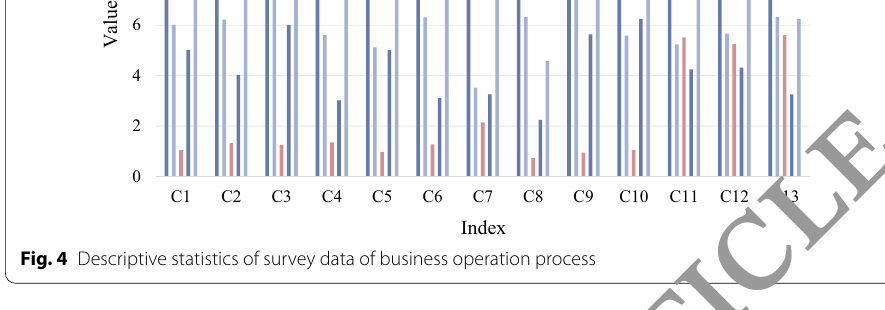
Fig. 4 Descriptive statistics of survey data of business operation process